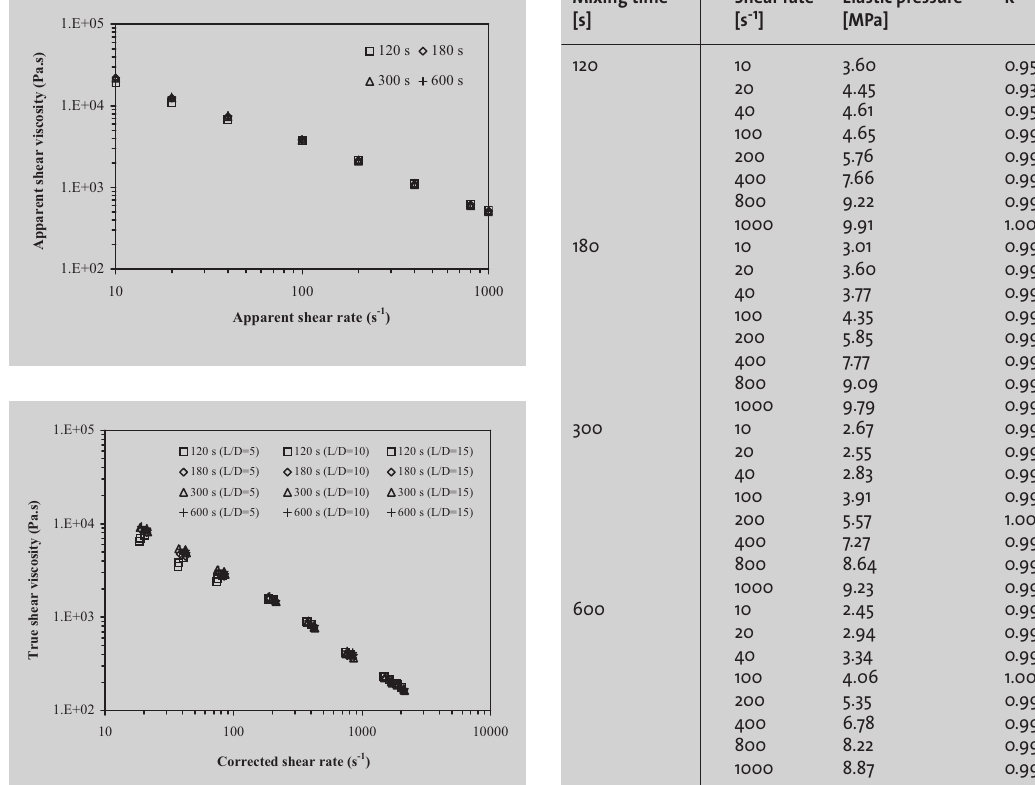
Figure 11 (left above): Capillary flow curves of uncured CPE/NR blends with the various mixing time (L/D = 15). Figure 12 (left below): Capillary flow curves after corrections of filled uncured CPE/NR blends with various mixing time and die geome- try. Table 3: Results determined from the Bagley